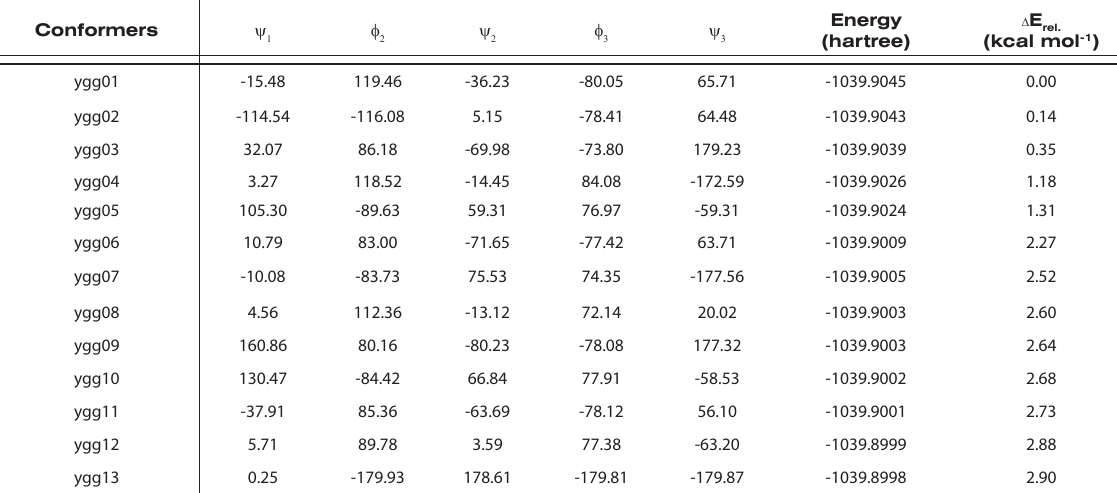
Table 1. Torsional angles and total energy values for the 13 most stable conformers of YGG optimized at RHF/6-31G(d) level of theory. Calculated relative energies (DE ) a are also shown. Total energies were given in hartrees, and the relative energies in kilocalories per mole. rel.